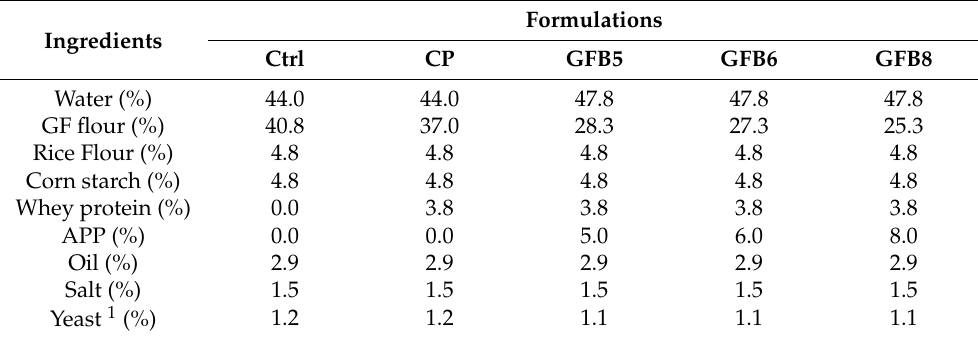
Table 1. List of ingredients of each sample batch and their relative amounts, expressed as percentage of the complete dough